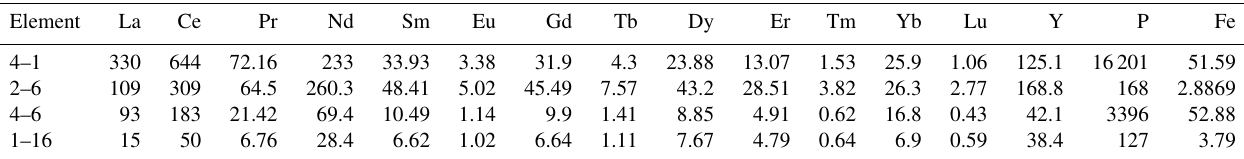
Table 3. Concentrations of REEs (ppm), P (ppm) and Fe (%) for the samples of Fig. 7. Element La